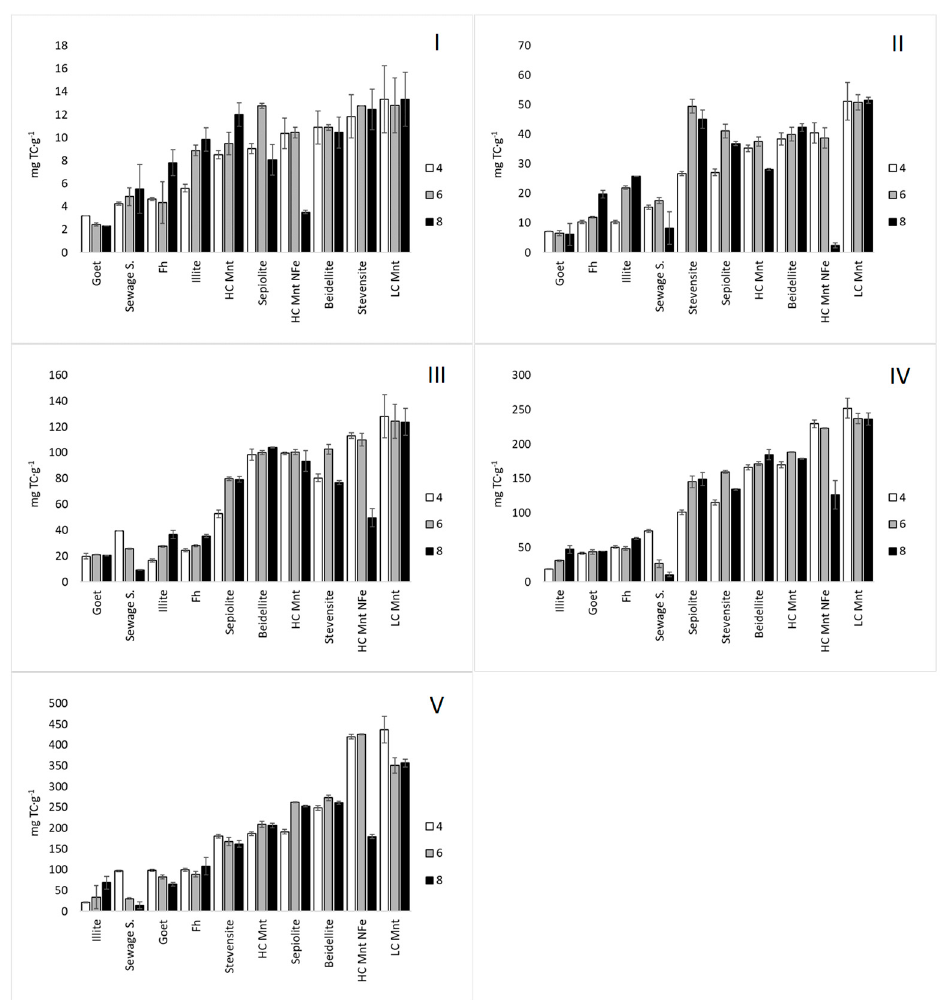
Figure 7. Sorption capacity of tetracycline (TC) (mg · g − 1 ) on tested mineral sorbents; Ferrihydrite (Fh), goethite (Goet), illite, calcined sewage sludge (Sewage S.), sepiolite, stevensite, non-iron high-charge montmorillonite (HC Mnt NFe), high-charge montmorillonite (HC Mnt), low-charge montmorillonite (LC Mnt), beidellite at those pH levels of 4 (white), 6 (grey) and 8 (black) and at those tested TC concentrations of ( I ) 33.2; ( II ) 131.6; ( III ) 322.6; ( IV ) 625.0 and ( V ) 1176.5 mg TC · L − 1 .